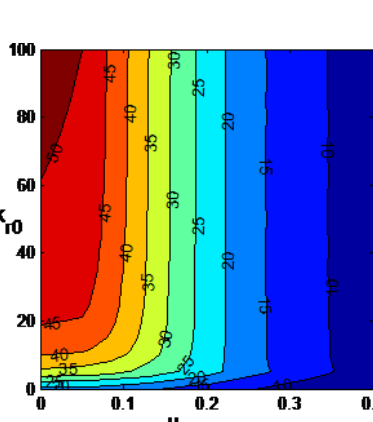
is simply supported. It is observed that the buckling load in-